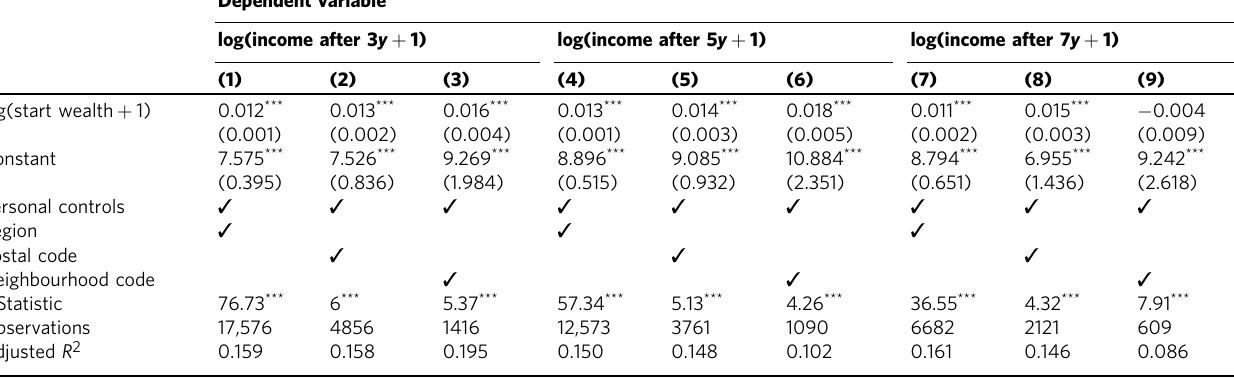
Table 1 The effect of starting wealth on income growth three years (columns 1 – 3), fi ve years (columns 4 – 6), and seven years (columns 7 – 9) into a career using ordinary least squares (OLS)